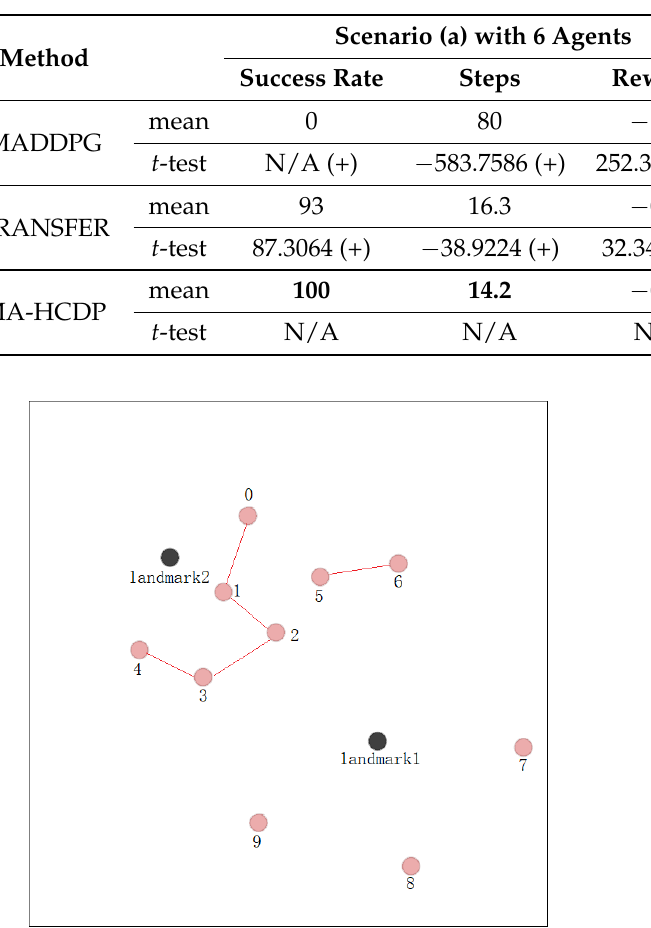
Table 3. Evaluation results of group containment.